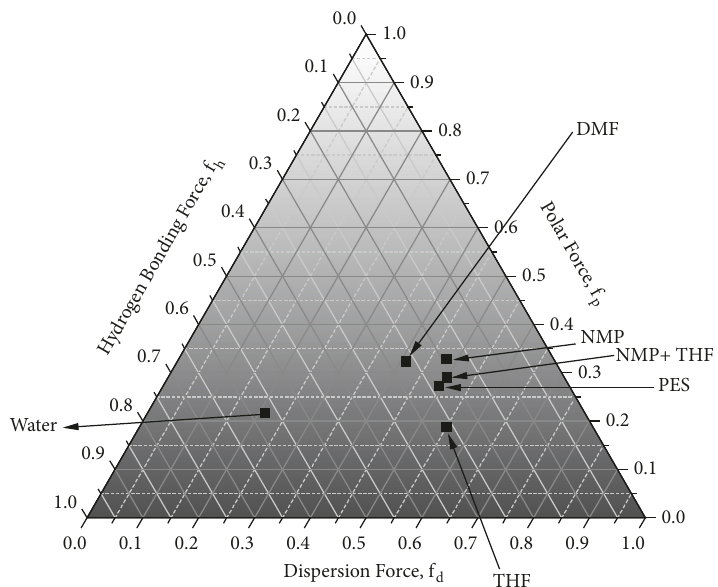
Figure 8: Teas graph of solubility parameter interaction of polymer, solvent, and